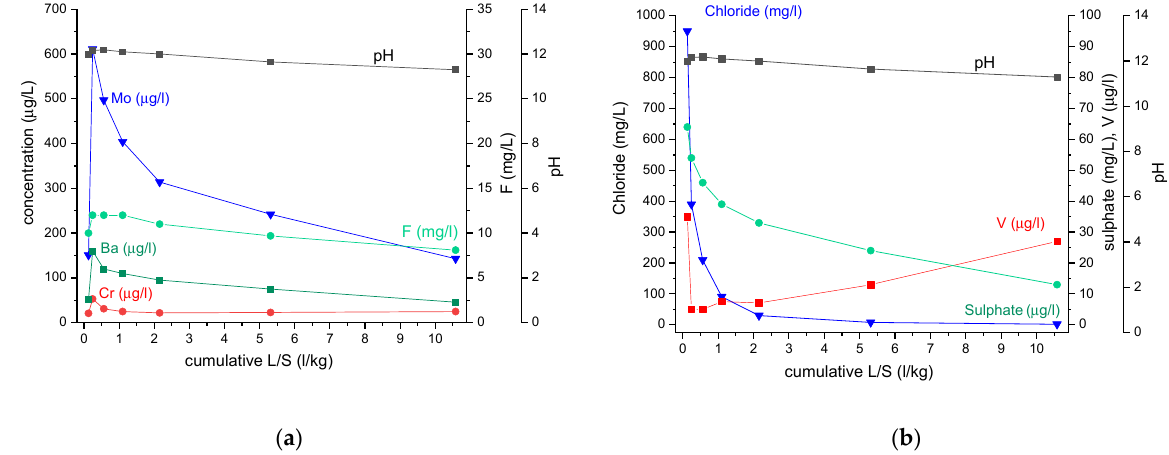
Figure 9. Leaching behavior of paver aggregates as a function of cumulative L/S. ( a ) Leaching of Ba, Cr, F and Mo ( b ) Leaching of chloride, sulphate and V. Table 4. Pearson’s correlation coefficient based on the leachate concentrations in fractions 2 to 7. Green is a strong correlation, orange is a medium correlation.